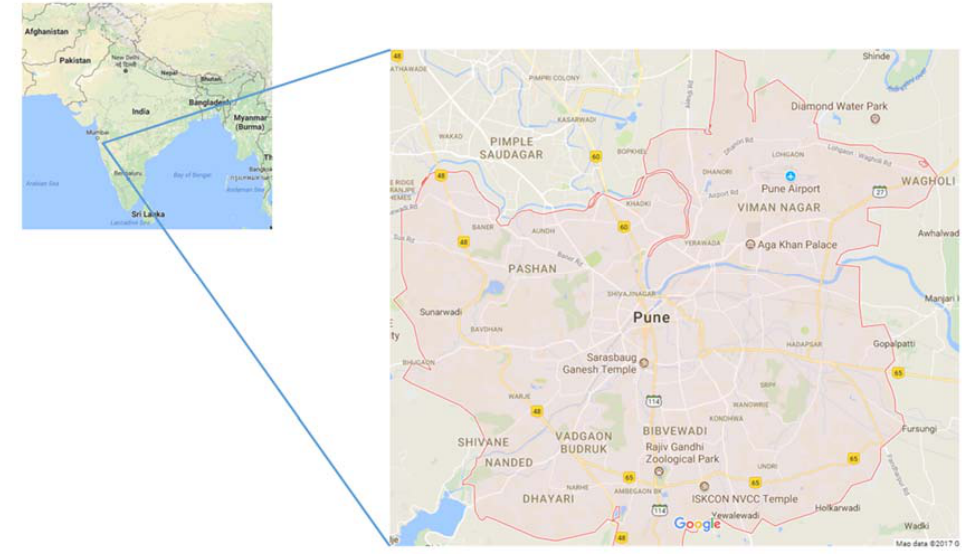
Figure 2. Map showing location of Pune in India (Source: Google maps www.goo.gl/ED9SHA). Table 1. List of various agencies and Projects involved in planning and implementation of adaptation responses in Pune.